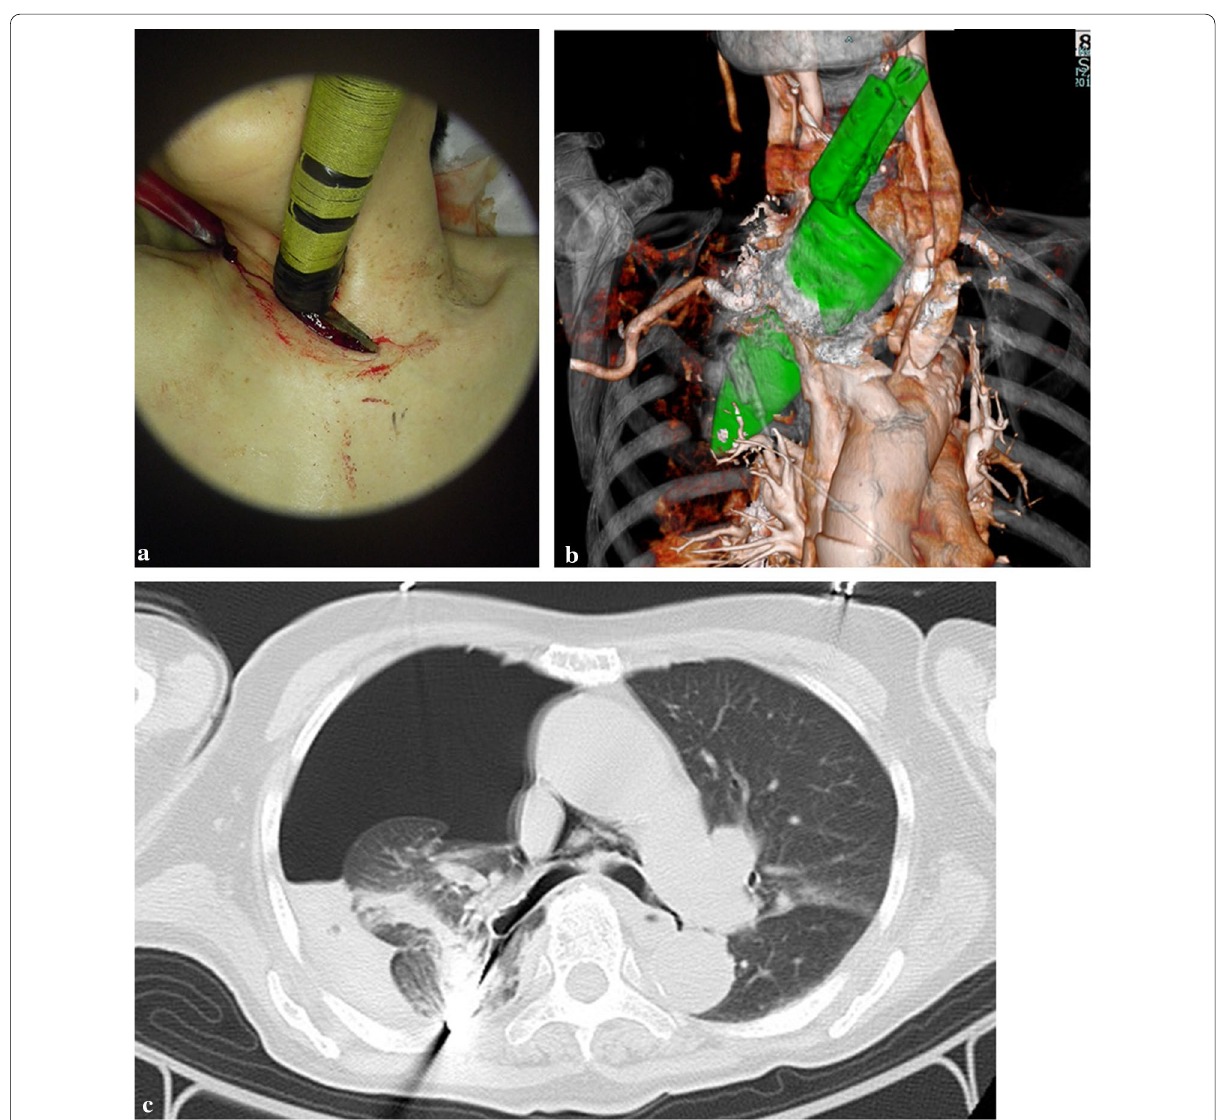
Fig. 1 Preoperative image. a A broad-blade kitchen knife penetrating the neck. b Three-dimensional reconstruction from the preoperative computed tomography scan. The knife pierced through the left side of the right brachiocephalic vein and into the right thoracic cavity. c Chest computed tomography showed a right hemopneumothorax with collapse of about half of the right lung and a small amount of thoracic